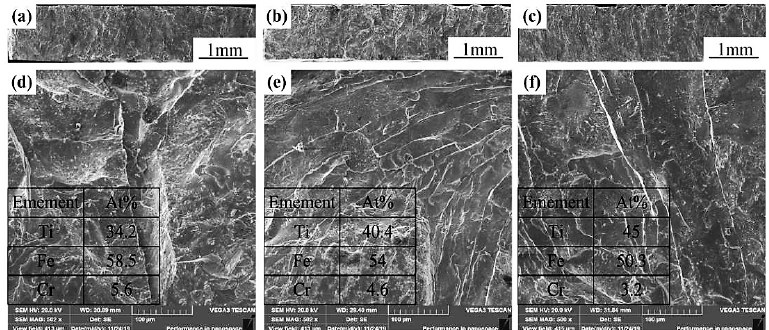
Figure 11. SEM images of fracture surfaces of 301L/TA2 welded joints: ( a – c ) Overall morphology of fracture surface with offset of − 0.3 mm, 0 mm, and +0.3 mm, respectively; ( d – f ) magnified images of fracture surface with offset of − 0.3 mm, 0 mm, and +0.3 mm, respectively.